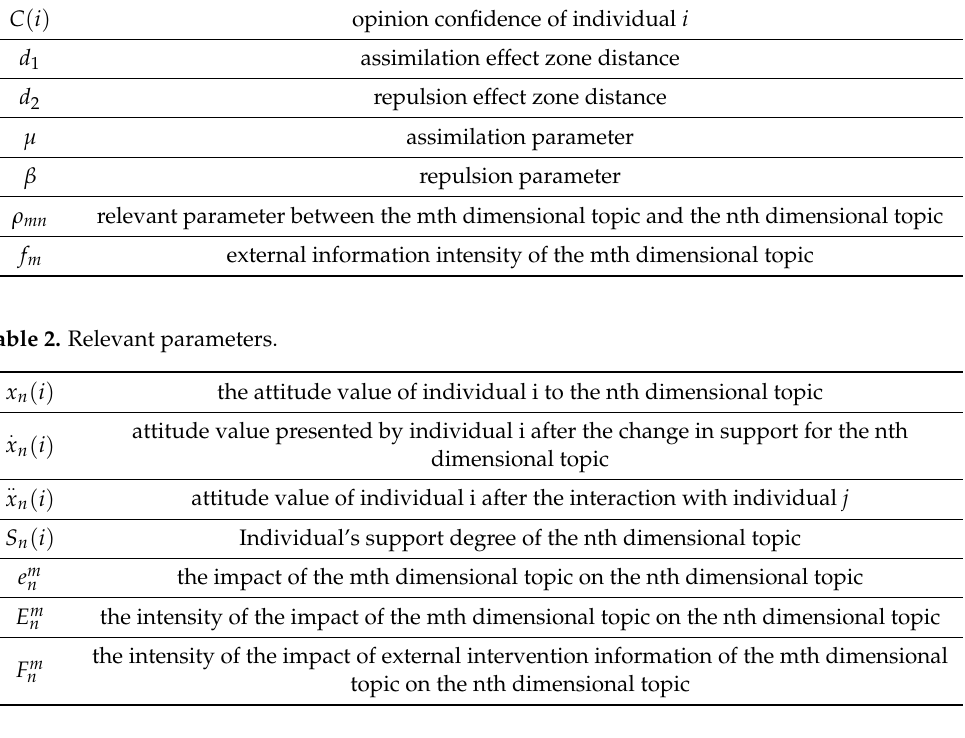
Table 1. Relevant parameters.